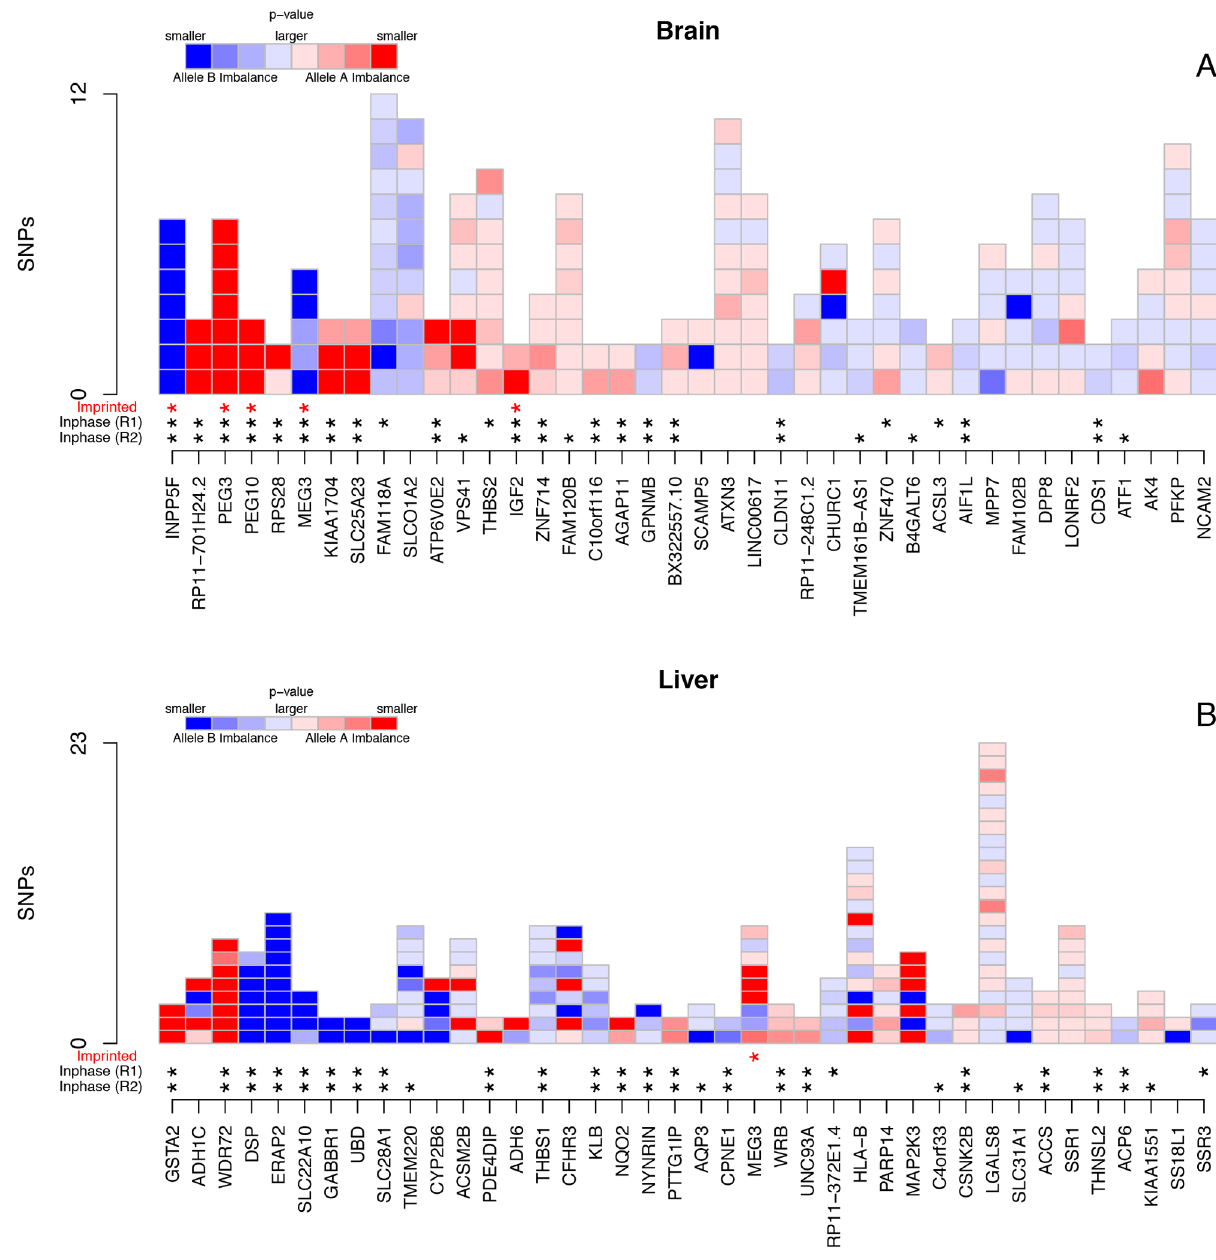
Fig 5. Highest ranked ASE genes from (A) brain and (B) liver. Each gene is shown as vertical bars of exonic SNPs testable within that gene. Red boxes are imbalanced towards haplotype A, and blue boxes imbalanced towards haplotype B, darker colours indicate more significant the level of imbalance. All data presented is the average of the two replicates. Genes are ordered left to right by the probability of gene imbalance. Stars below the bars indicate whether the gene is known imprinted (red), or whether the SNPs for that gene all show concordant direction of expression imbalance in each replicate (black). Each of the tissues has a cluster of genes with very significant SNPs mostly with concordant direction of ASE towards the left of the plots (strong genic ASE). It is clear, however, that some genes contain SNPs that vary in their direction and magnitude of imbalance.